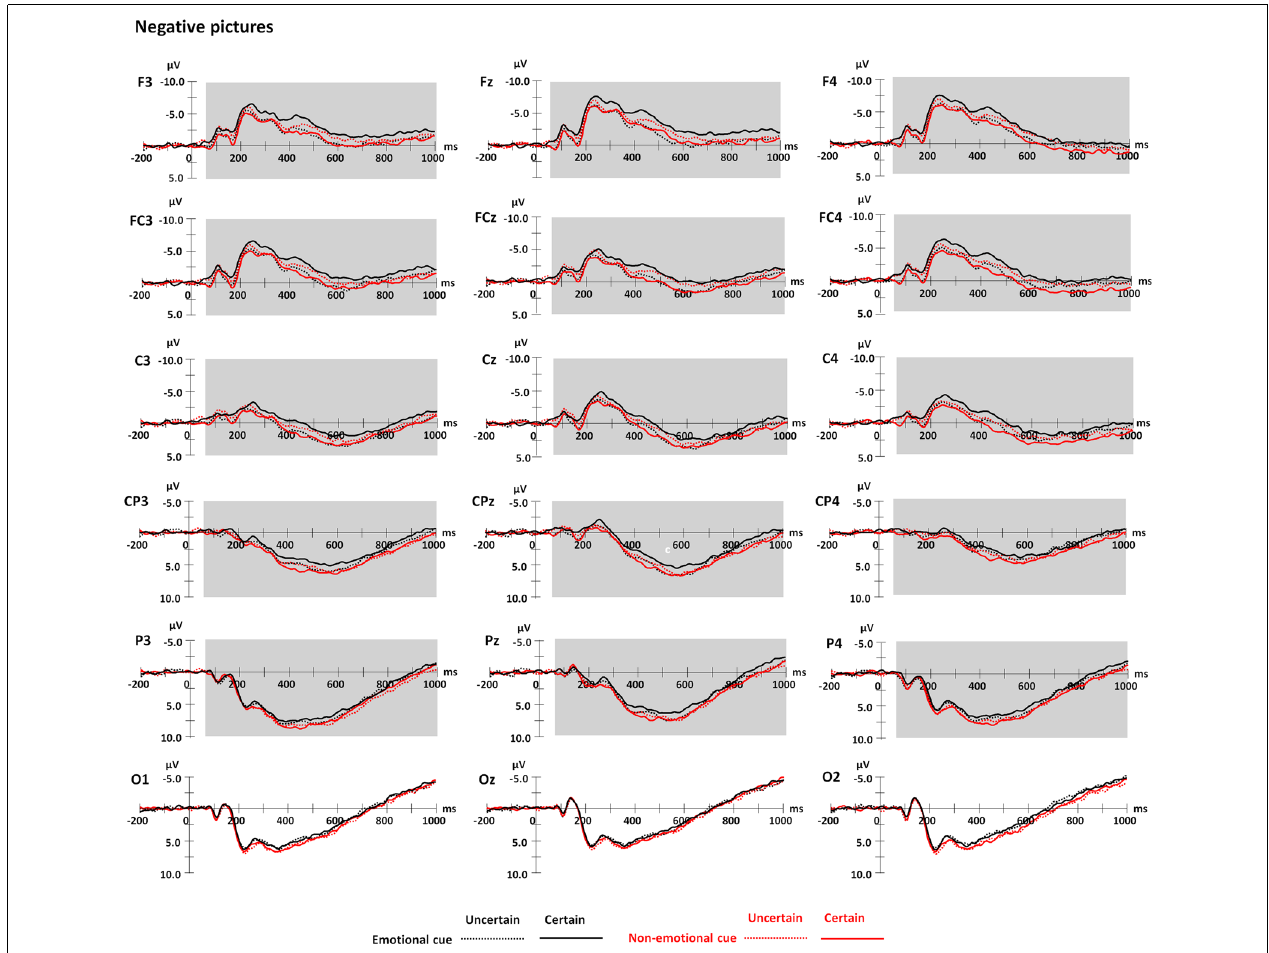
FIGURE 3 | Grand average waveforms for negative pictures varying in cue valence, cue uncertainty, and emotion. Shaded areas represent the time window for frontocentral and centroparietal ERPs (60–1,000